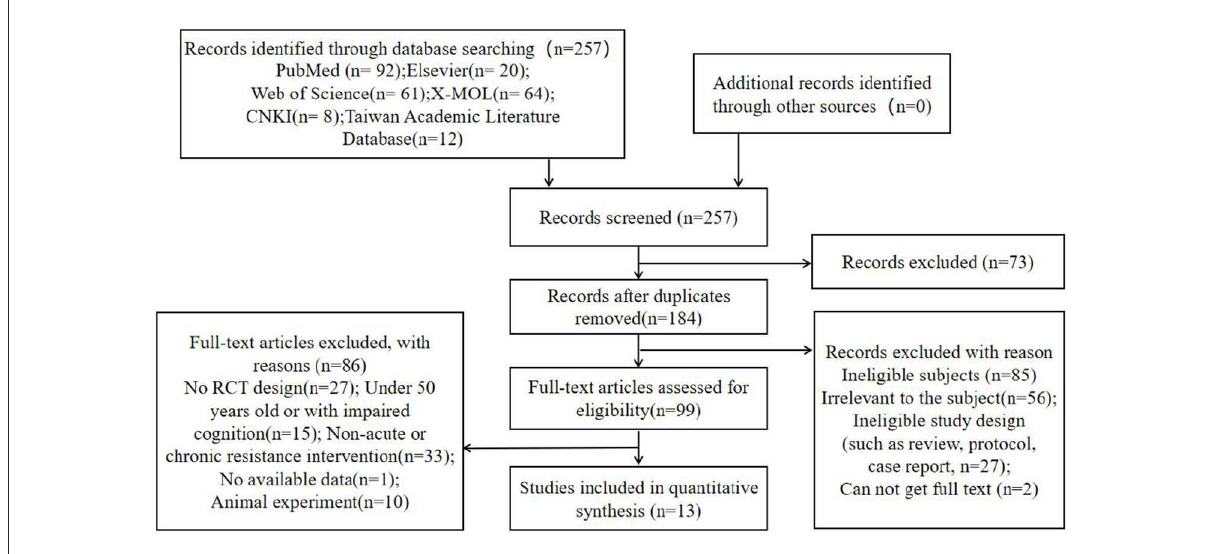
FIGURE1 Flow chart with information about the search, screening, and selection